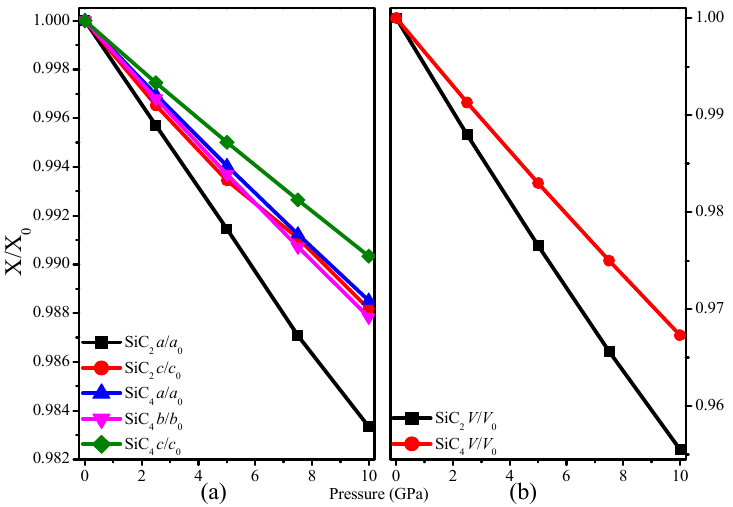
Figure 2. The compression lattice constants a / a 0 , b / b 0 , c / c 0 as functions of pressure SiC 2 ( a ) and SiC 4 ( b ).